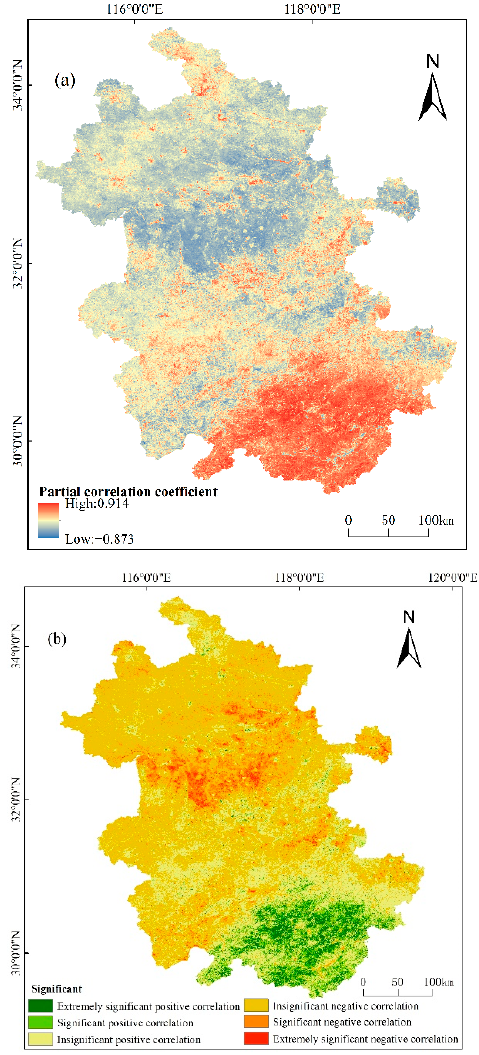
Figure 9. Partial correlation coefficient between NDVI and temperature and distribution of signifi- cance level: ( a ) partial correlation coefficient between NDVI and temperature, its value ranged from − 0.873 to 0.914; ( b ) distribution of significance level, divided into 6 grades by significance test using t statistic: extremely significant positive correlation, significant positive correlation, insignificant positive correlation, insignificant negative correlation, significant negative correlation, and ex- tremely significant negative correlation.